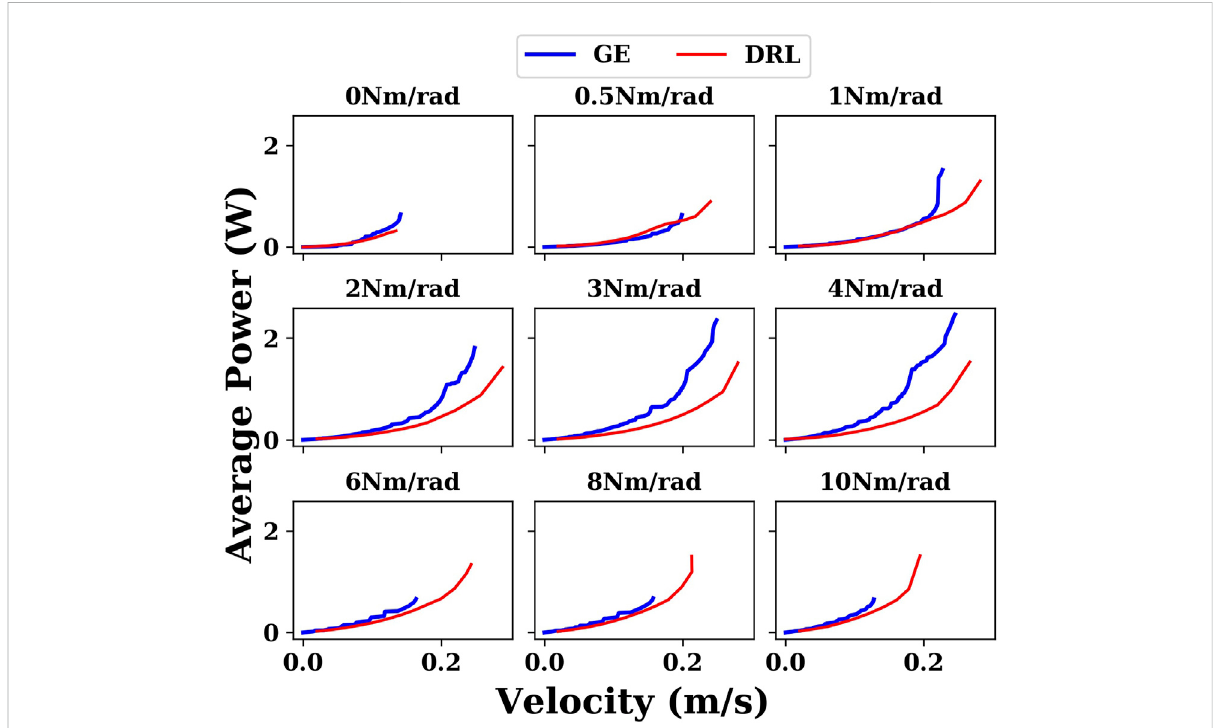
FIGURE 8 Comparison oftheresultsgeneratedbythegaitequation controllerandDRLcontrollerwithdifferentjointstiffnessesinthewaterenvironment.